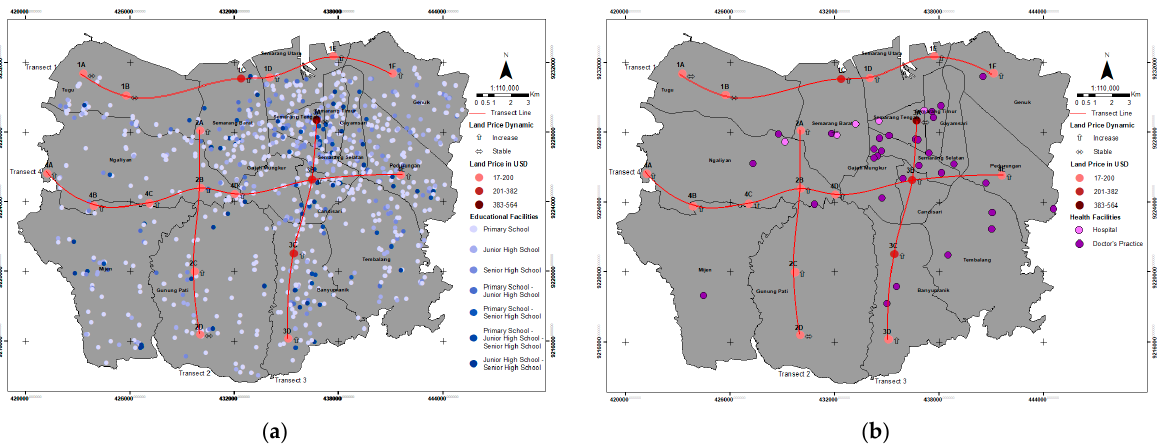
Figure 5. The distribution of basic facilities contributing to the values of land in Semarang City: ( a ) Educational facilities; ( b ) Health facilities.